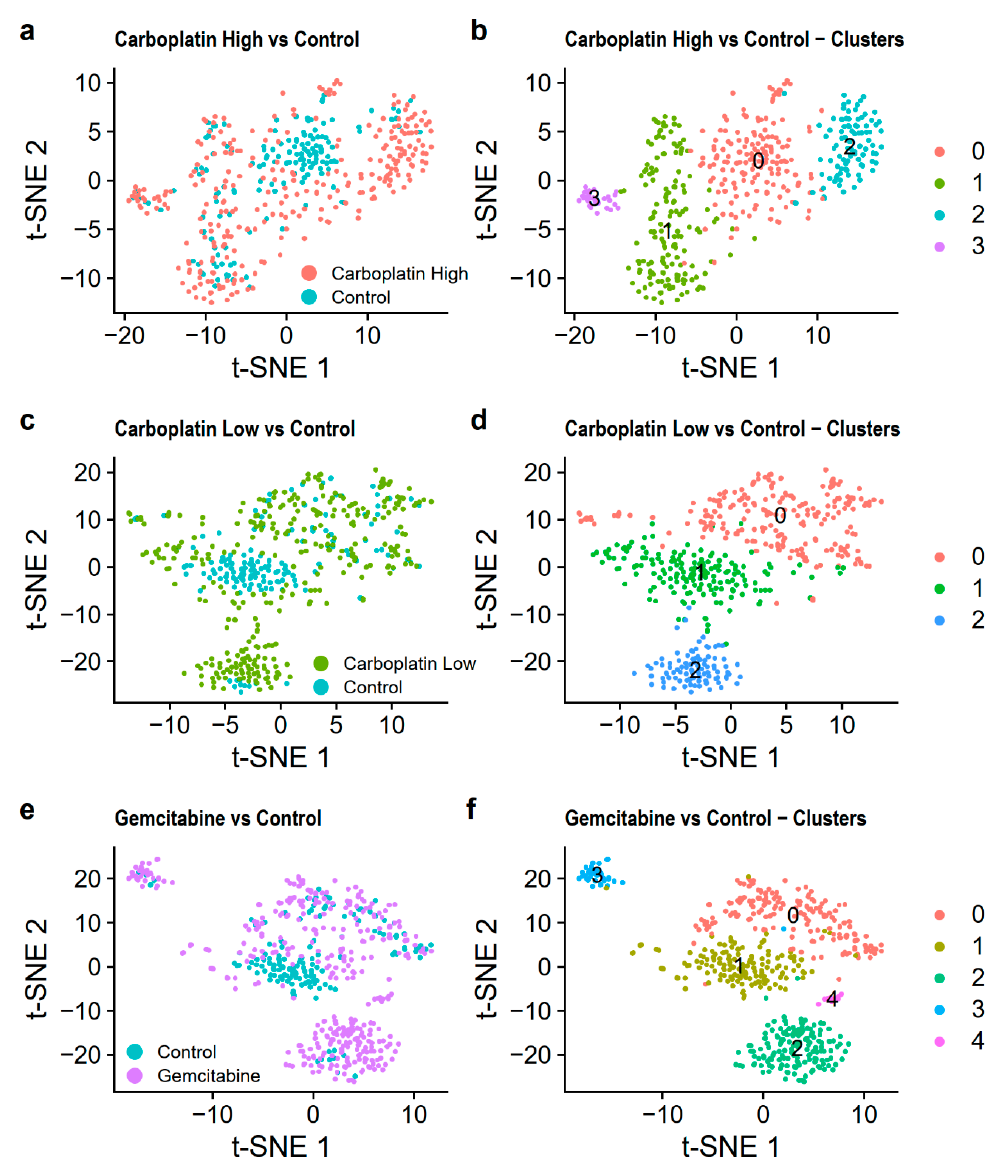
Figure 6. Visualization of the merged datasets using t-SNE. Carboplatin High vs. Control is shown colored ( a ) by the treatment and ( b ) by the identified clusters. Carboplatin Low vs. Control is shown colored ( c ) by the treatment and ( d ) by the identified clusters. Gemcitabine vs. Control is shown colored ( e ) by the treatment and ( f ) by the identified clusters.